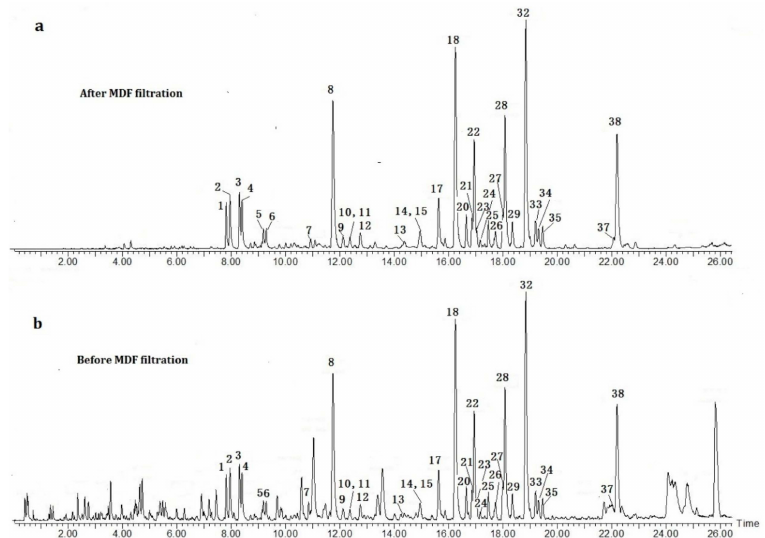
Figure 4. The ultra-high-performance liquid chromatography tandem quadrupole time-of-flight mass spectrometry (UHPLC-QTOF-MS) base peak intensity (BPI) chromatograms of B. aromatica. : ( a ) After MDF filtration and ( b ) Before MDF